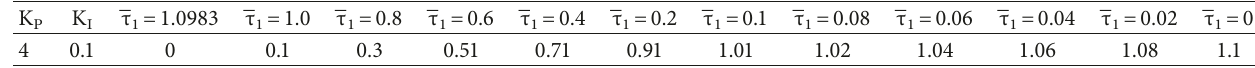
− 3, the highest acceptable delay bound τ ̅ 1